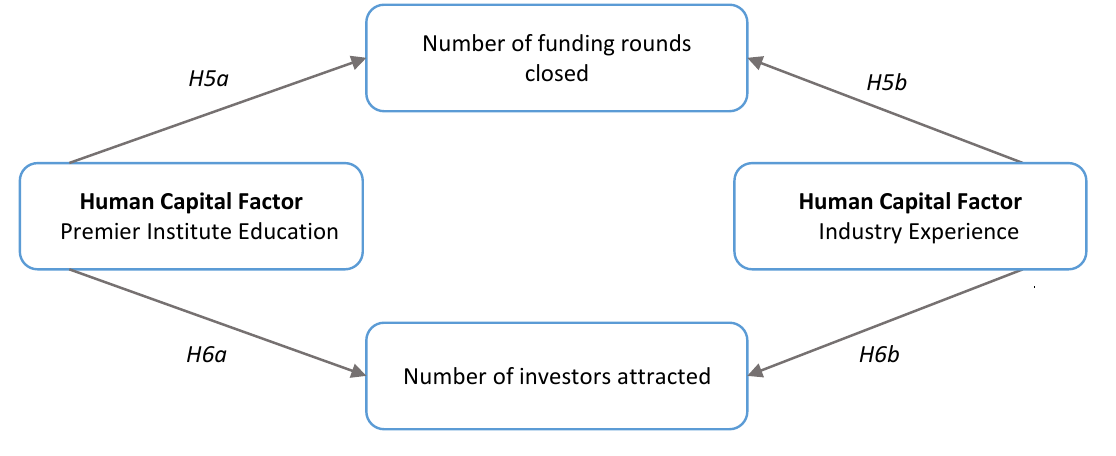
Figure 2. Number of funding rounds closed and number